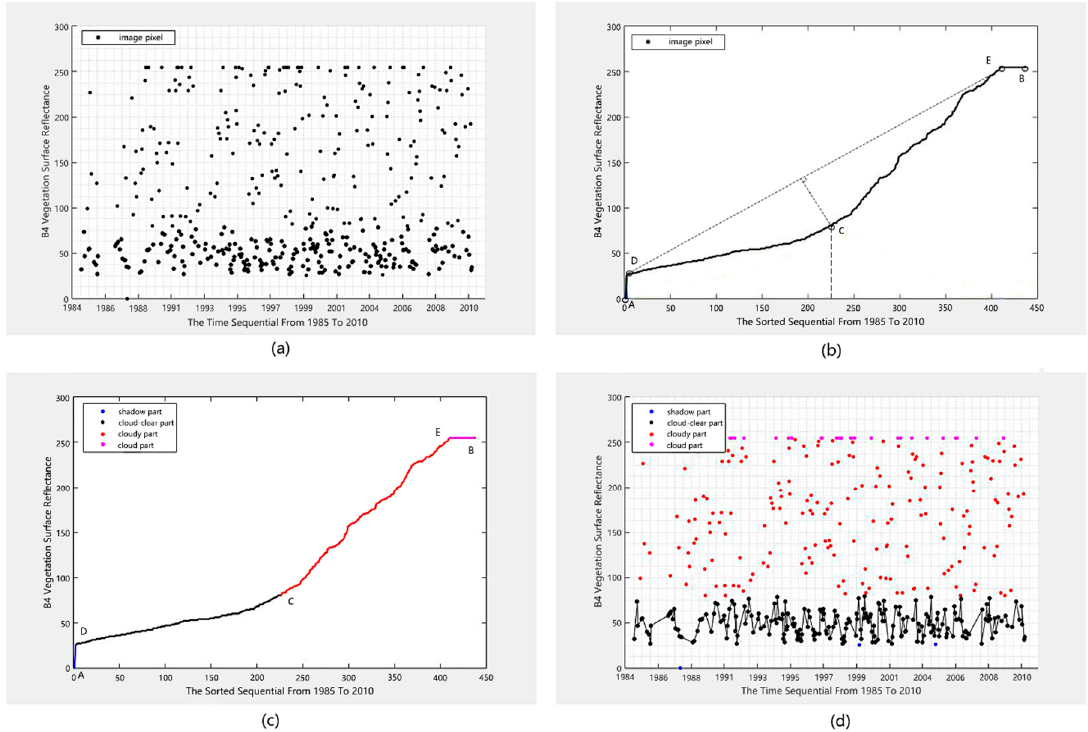
Figure 3. Schematic diagram of the time-series pseudo-invariant feature (PIF) extraction method based on the point of inflection. ( a ) Original gray-scale values for a typical selected pixel sorting according to their acquisition times; ( b ) gray-scale values sorted in ascending order, with A and B representing points with the smallest and largest gray-scale values, respectively. C, D and E are identified inflection points. ( c ) Segmentation results of a line segment using the sorted gray-scale values; and ( d ) inlier and outlier identification results using the method proposed in this paper.